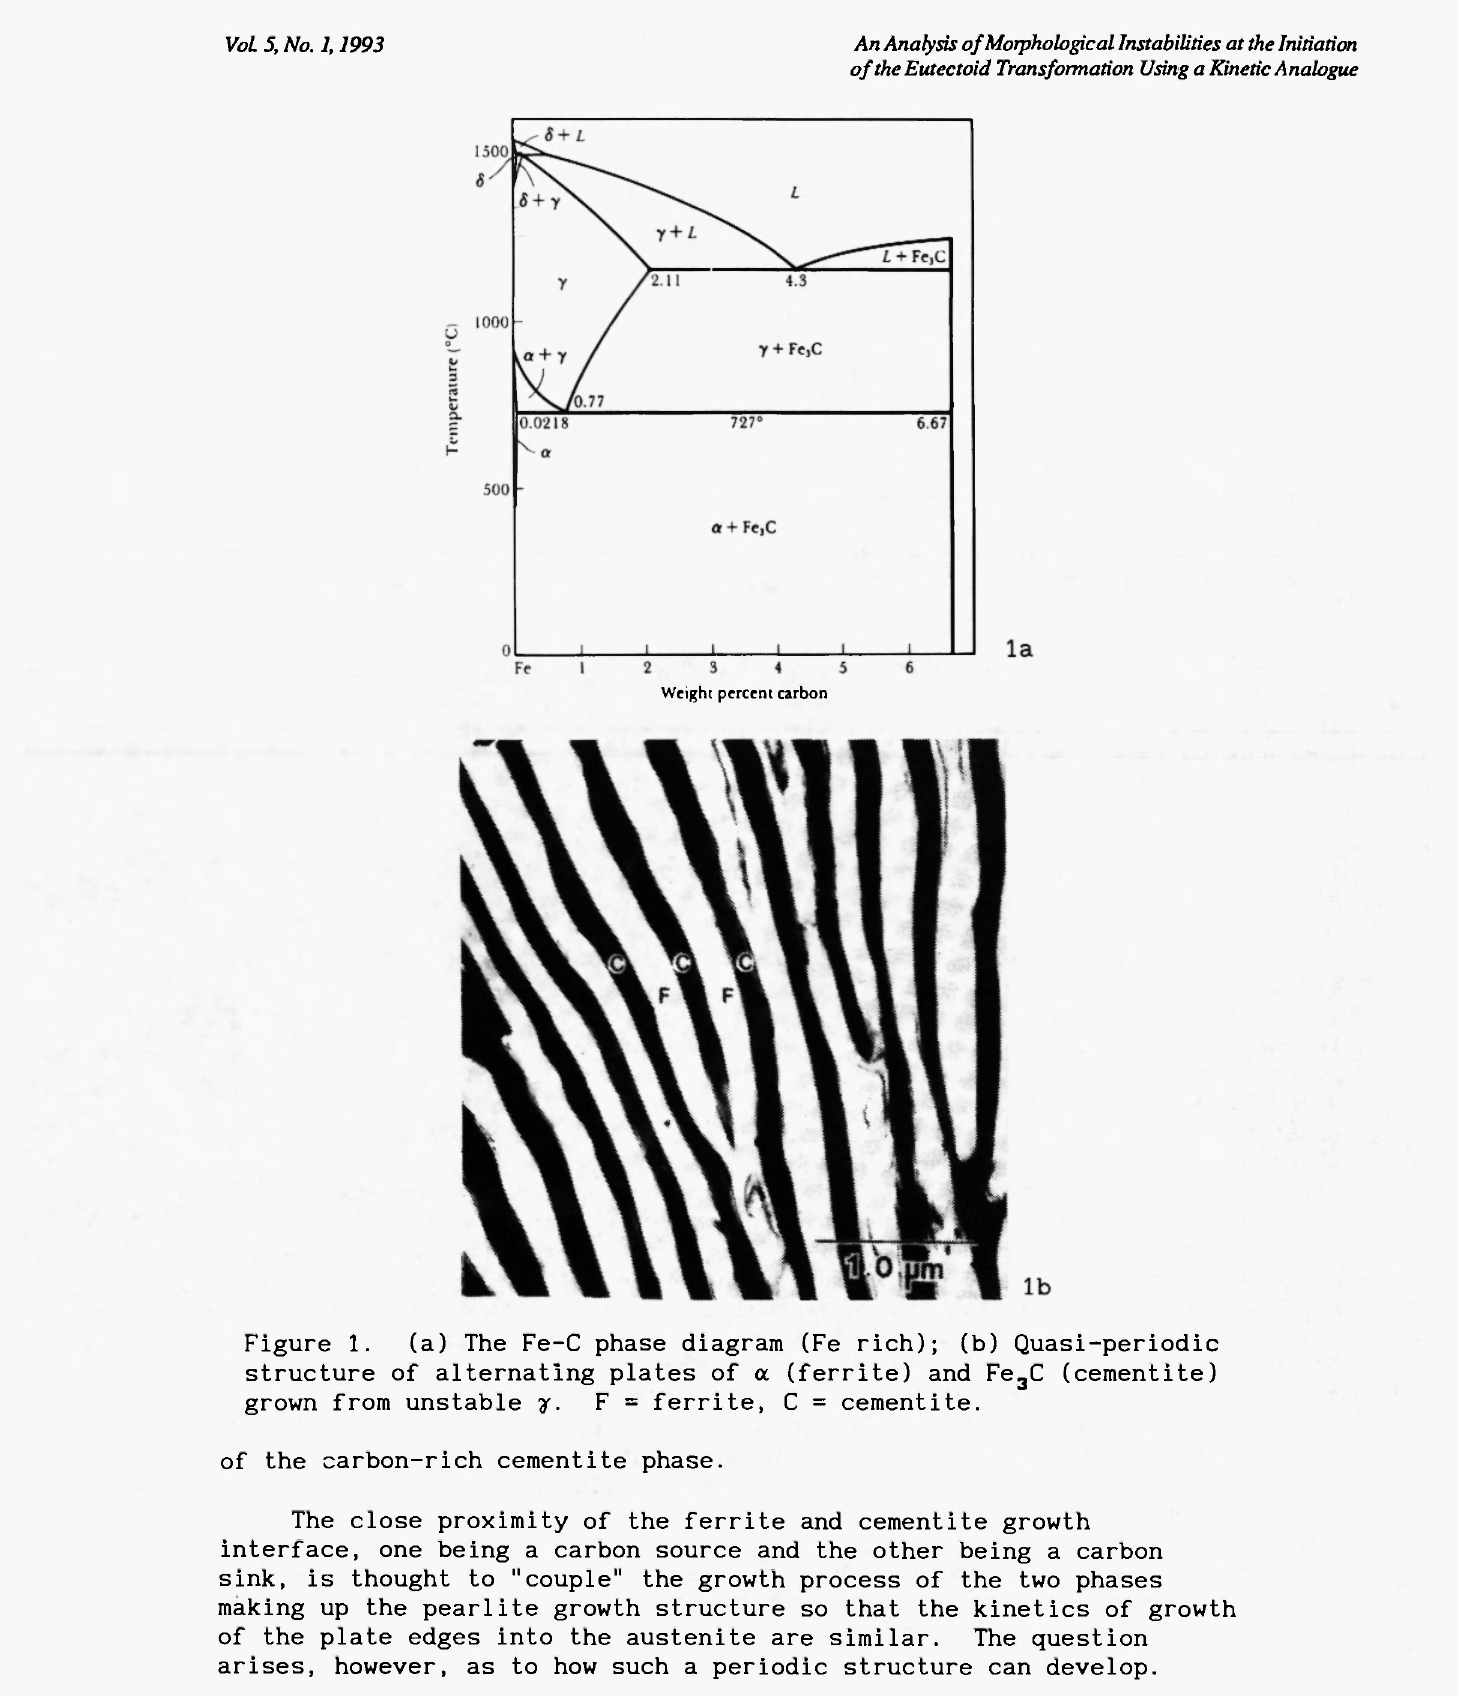
Figure 1. (a) The Fe-C phase diagram (Fe rich); (b) Quasi-periodic structure of alternating plates of α (ferrite) and Fe 3 C (cementite) grown from unstable γ. F = ferrite, C =